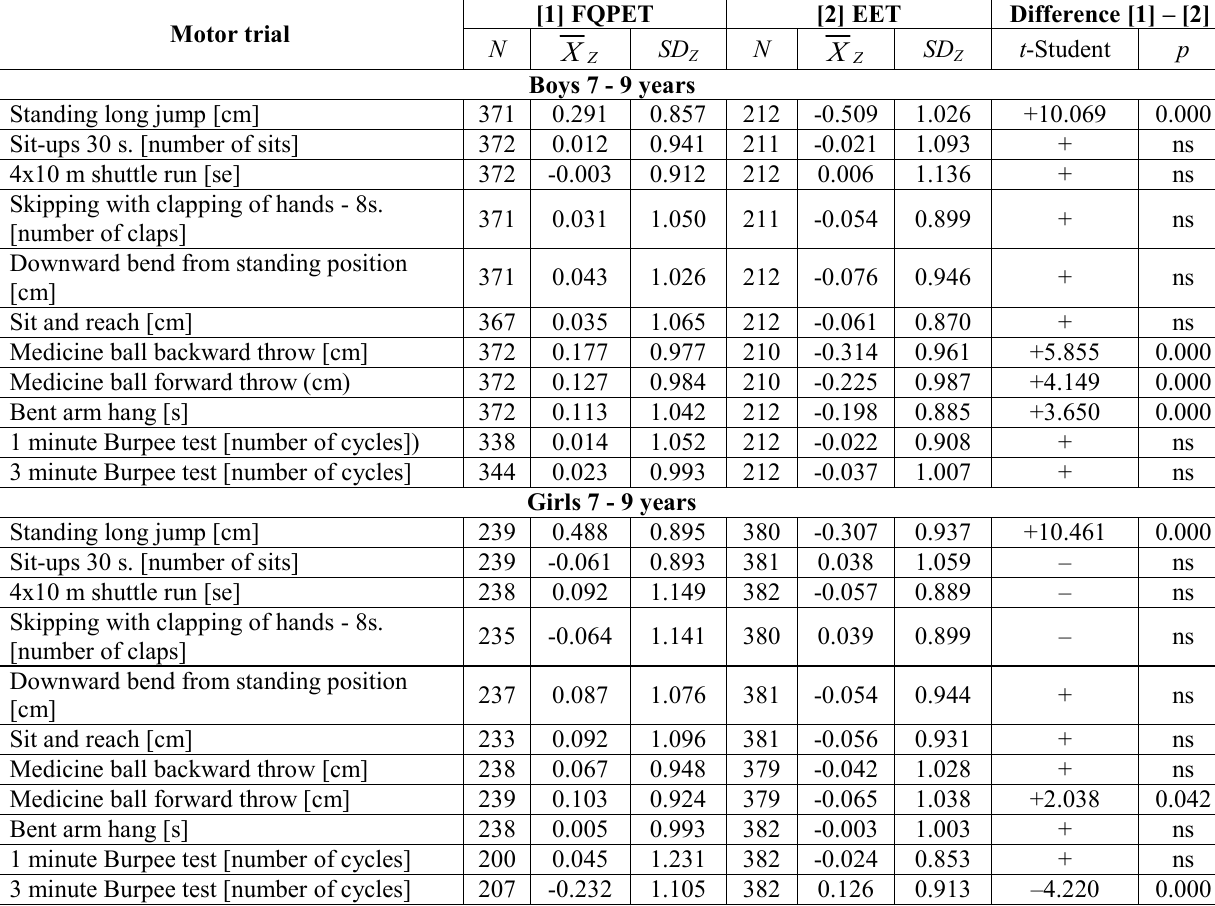
Statistical characteristics of Z-scores of boys’ and girls’ motor trial results in relation to teaching